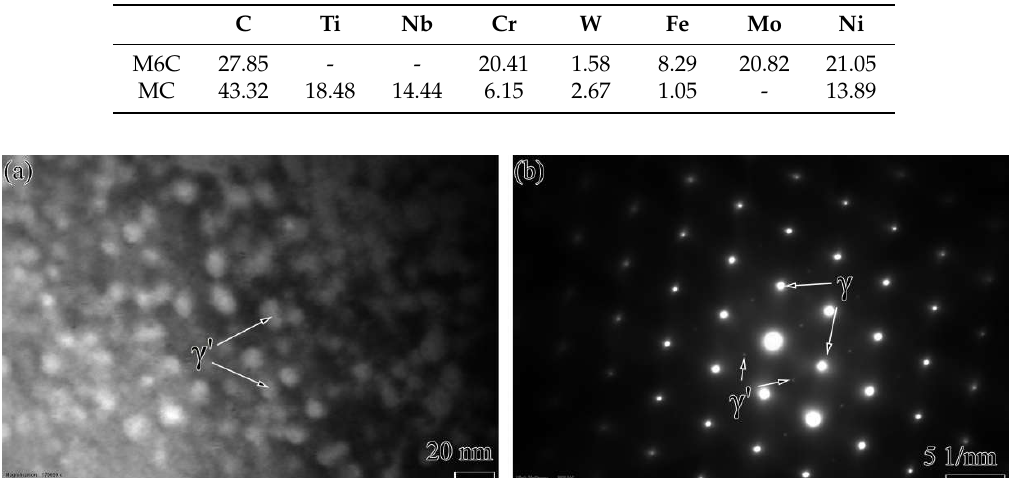
Figure 3. Microstructure of as-received base materials: ( a ) OM image of Hastelloy X alloy; ( b ) OM image of K4750 alloy; ( c ) SEM image of Hastelloy X; and ( d ) SEM image of K4750 alloy. Table 2. Compositions of carbides in the base metals (Atomic %). Table 2. Compositions of carbides in the base metals (Atomic %).